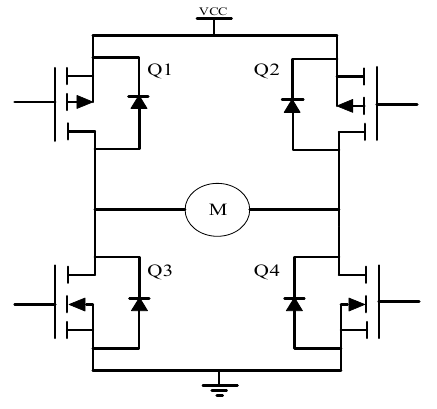
Figure 5. Basic principle of RVDT solution unit.